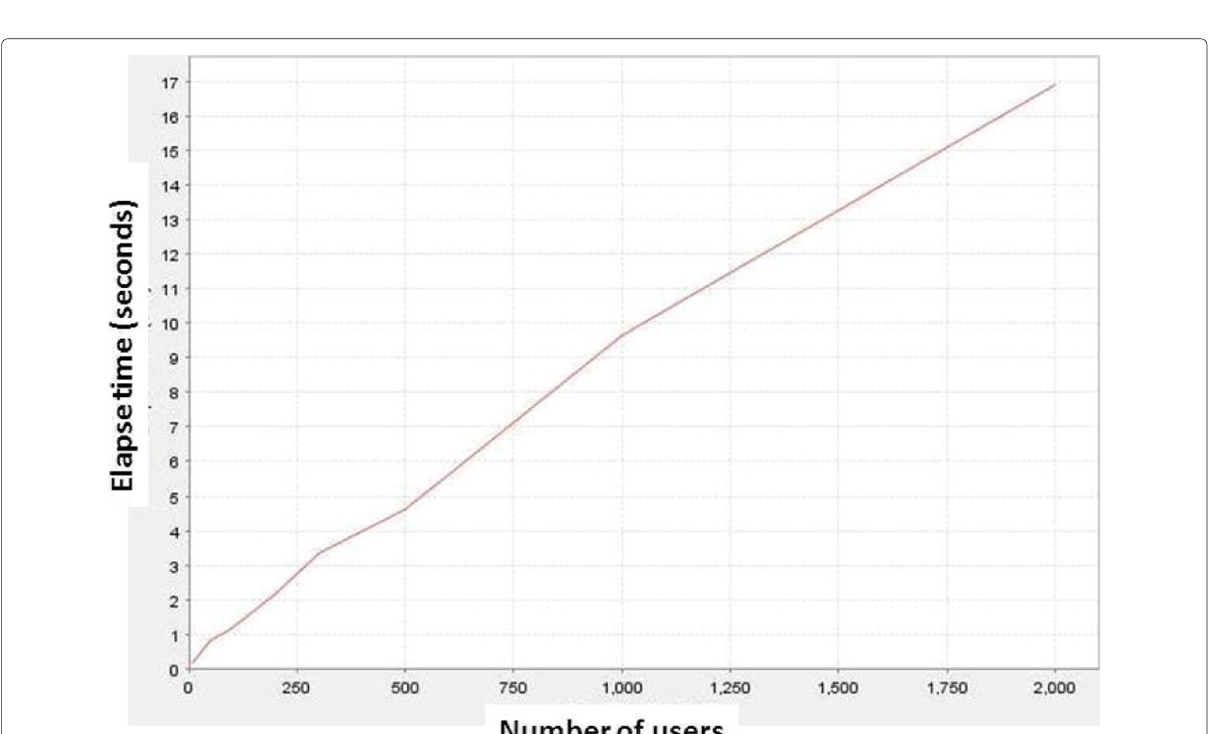
Fig. 15 Elapsed time performance of data owner machine for evaluating user